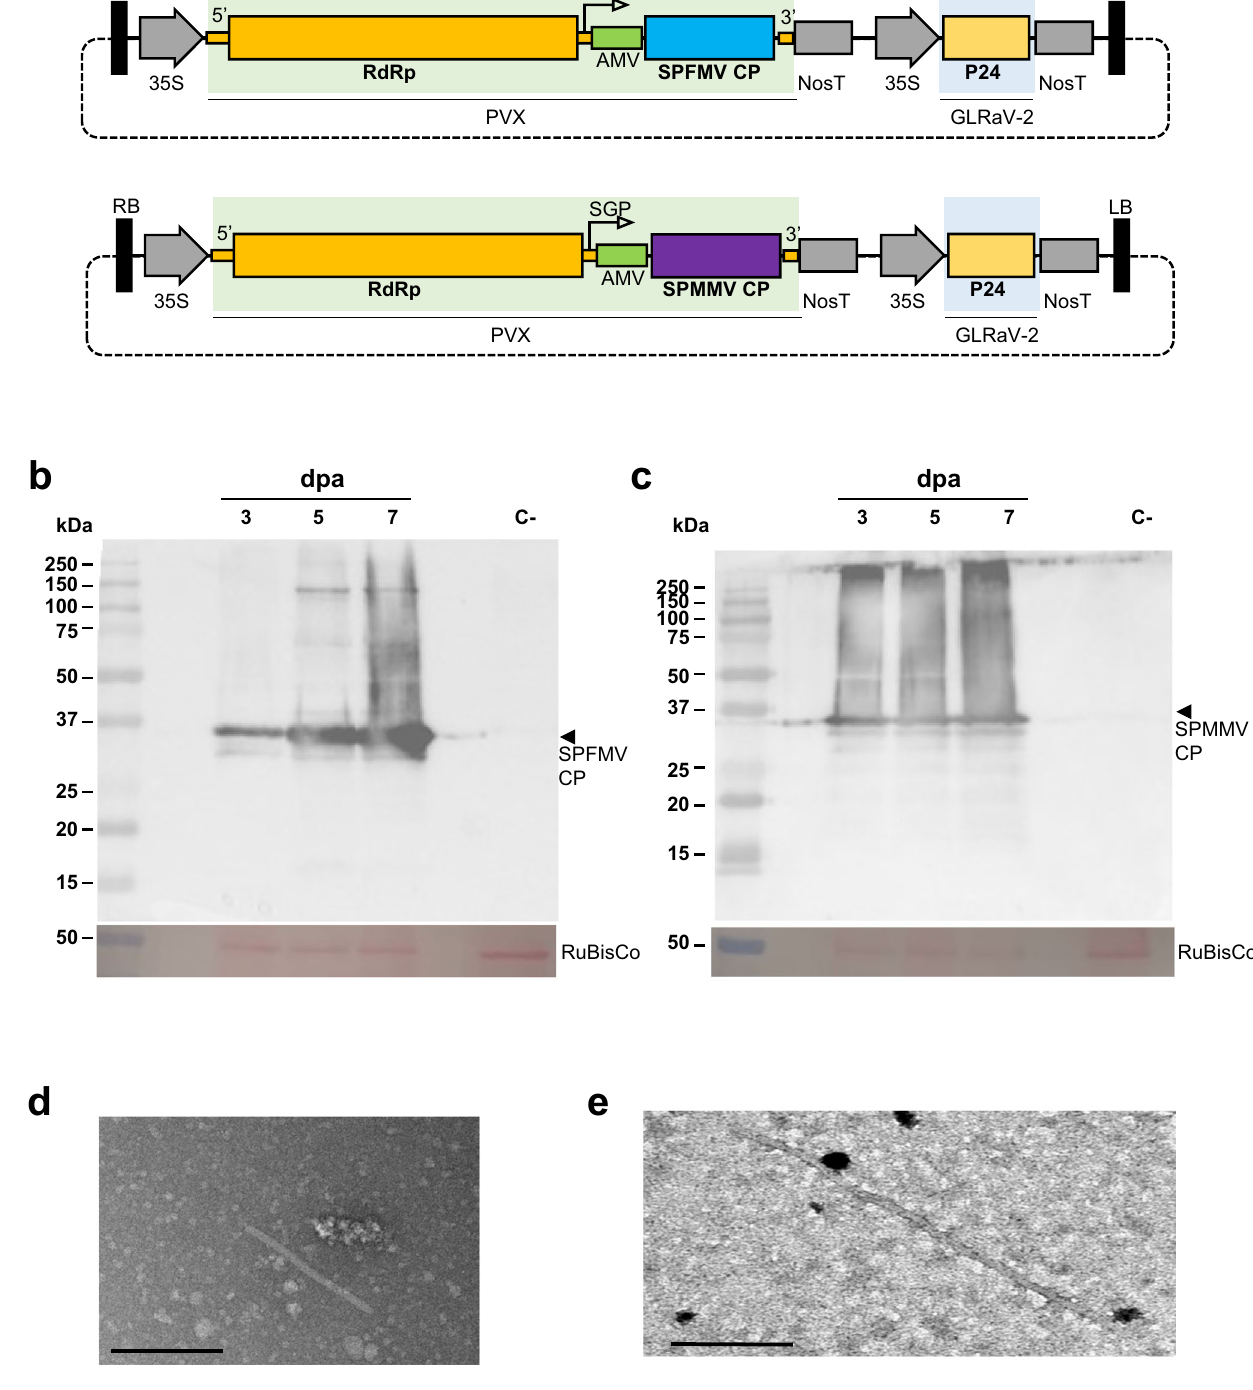
(Supplementary Fig. 1). TEM analysis of negatively stained samples revealed the presence of VLPs for both viruses (Fig. 1d, e) con fi rming that the pEff system provided an ef fi cient platform for the production of potyvirid